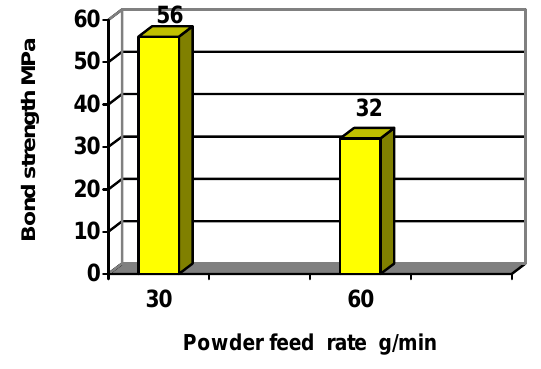
Figure 4 – Bond strength of Ni 5,5wt.%Al5 wt.%Mo layers Рис . 4 – Прочность сцепления Ni5,5 вес .%Al5 вес .%Mo слоев Слика 4 – Чврстоћа споја Ni5,5 теж .%Al5 теж .%Mo